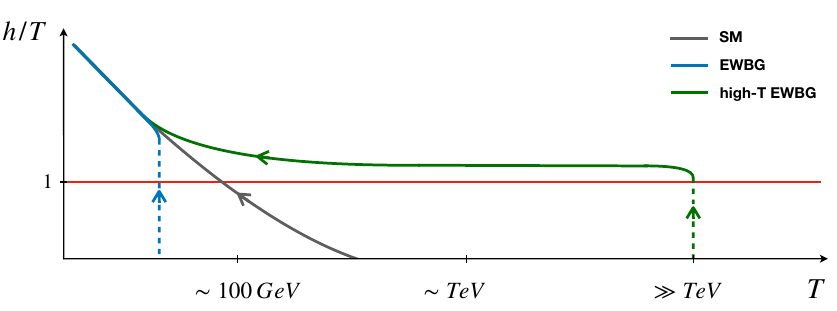
Figure 1 . Higgs VEV thermal histories in SM (grey), traditional models of electroweak baryoge- nesis (blue) and models of high-temperature EWBG (green). Dashed vertical lines correspond to first-order phase transitions. Red line shows the border between h/T 7 1 phases, which in EWBG models have to be separated by the first-order phase